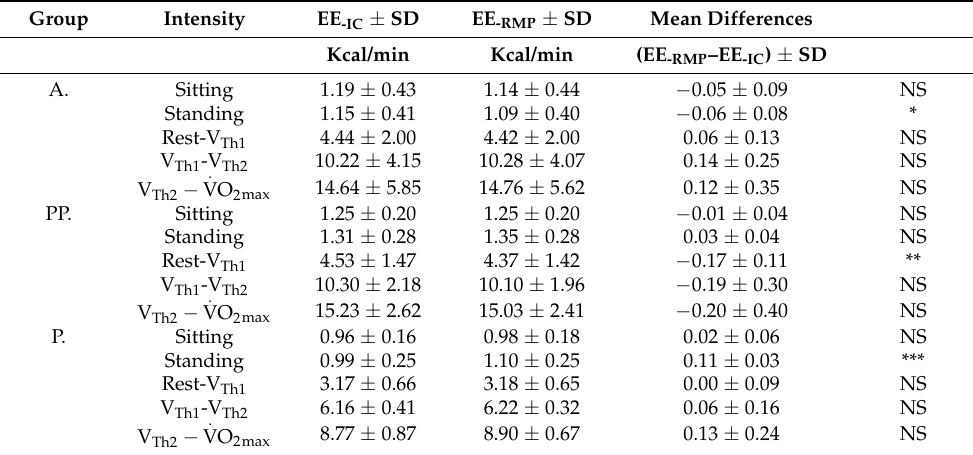
Table 3. Estimated (EE -RMP ) and measured (EE -IC ) energy expenditure mean values for each group and each intensity level.